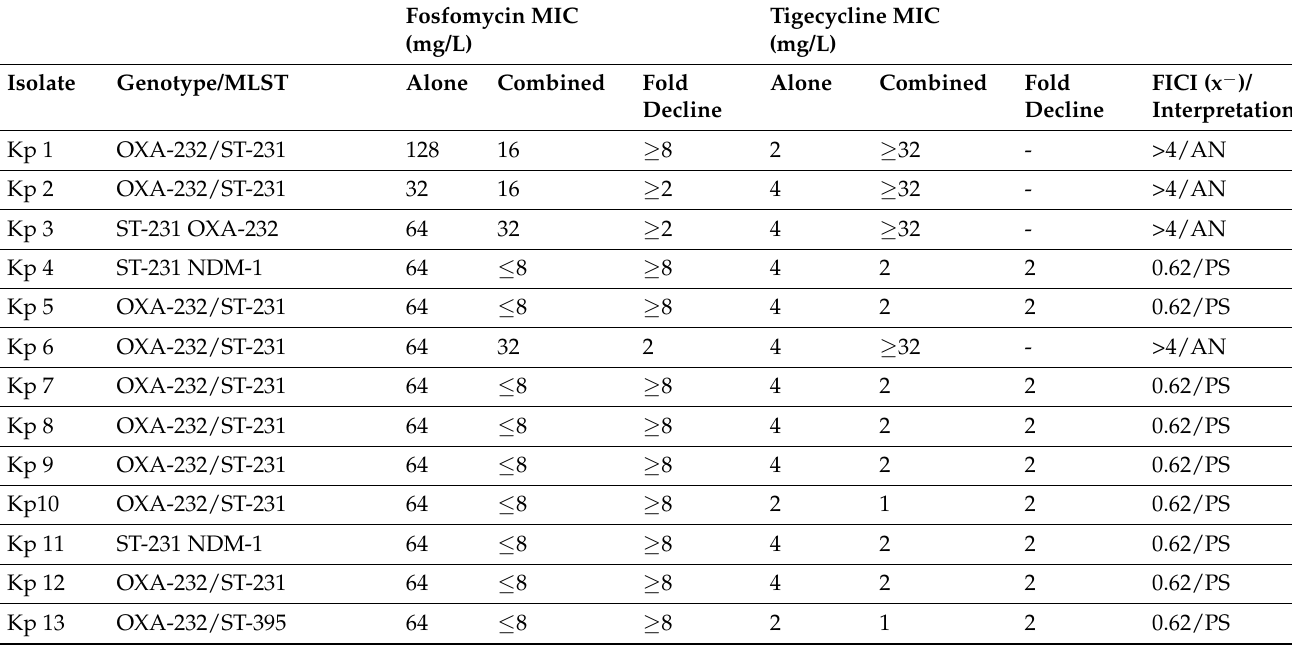
Table 5. Outcomes of fosfomycin-tigecycline combination using the Checkerboard assay. Fosfomycin MIC (mg/L)